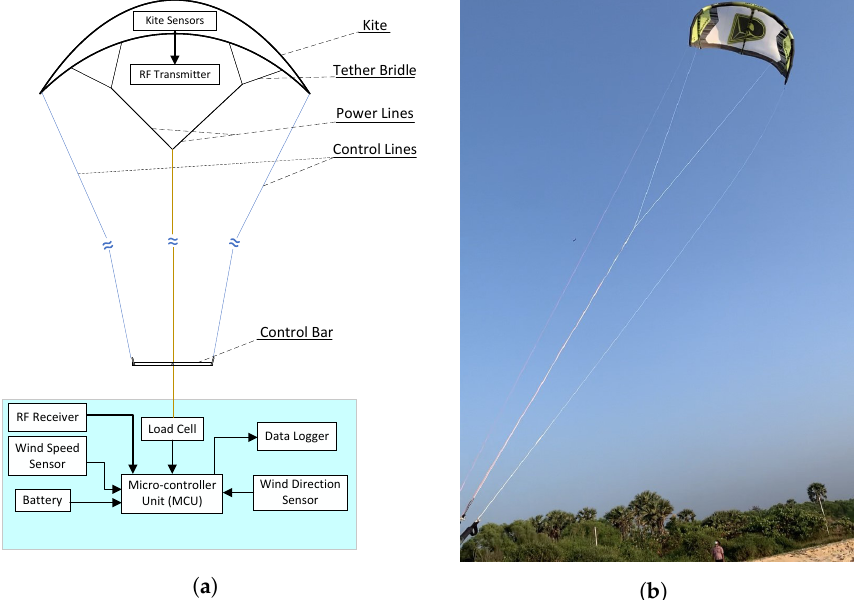
Figure 5. Experimental setup: ( a ) pictorial representation of the system used for estimating the tether force with a block diagram of the system, ( b ) Actual experimental setup used in the experimental tests. The kite’s measurement system was divided into on-air and on-ground